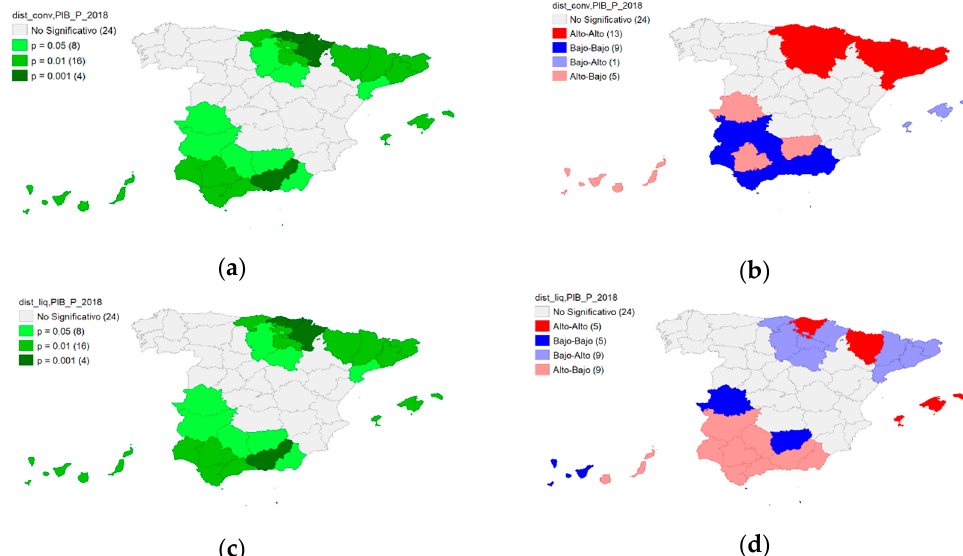
Figure 7. Significance and clusters maps for Moran’s Bivariant Index with Iag convenio and GDP per capita ( a , b ) and significance and clusters maps for Moran’s Bivariant Index with Iag liquidation and GDP per capita ( c , d ).